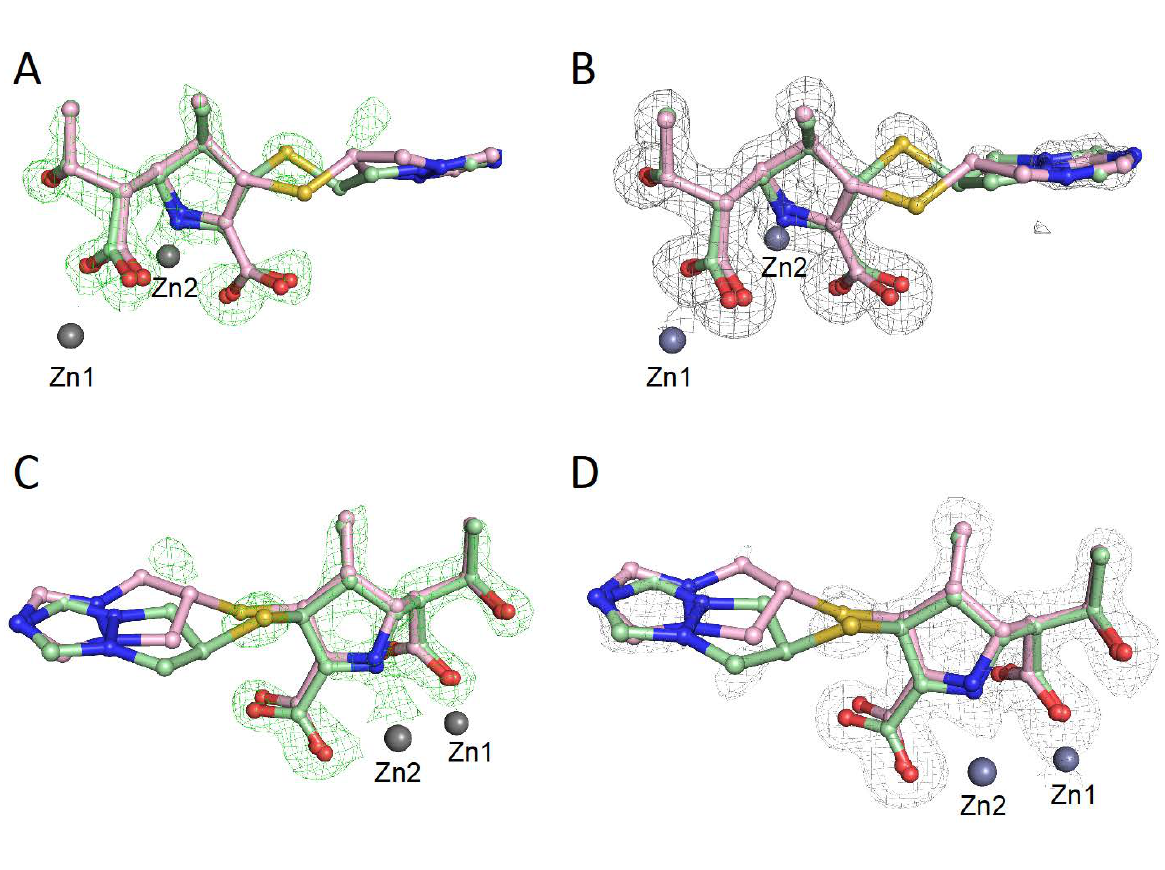
Figure 3. Electron density maps for biapenem-derived products in complex with VIM-2. (2 S )-Imine: pale green balls and sticks; enamine: pink balls and sticks. ( A ) and ( C ) show an OMIT map (green mesh) of mFo-DFc contoured to 3 σ (PDB: 6Y6J). ( B ) and ( D ) show the 2mFo-DFc difference map in grey mesh, contoured to 1 σ . Note the weak density for the biapenem-derived bicyclotriazolium sidechain, indicating the presence of multiple conformations.